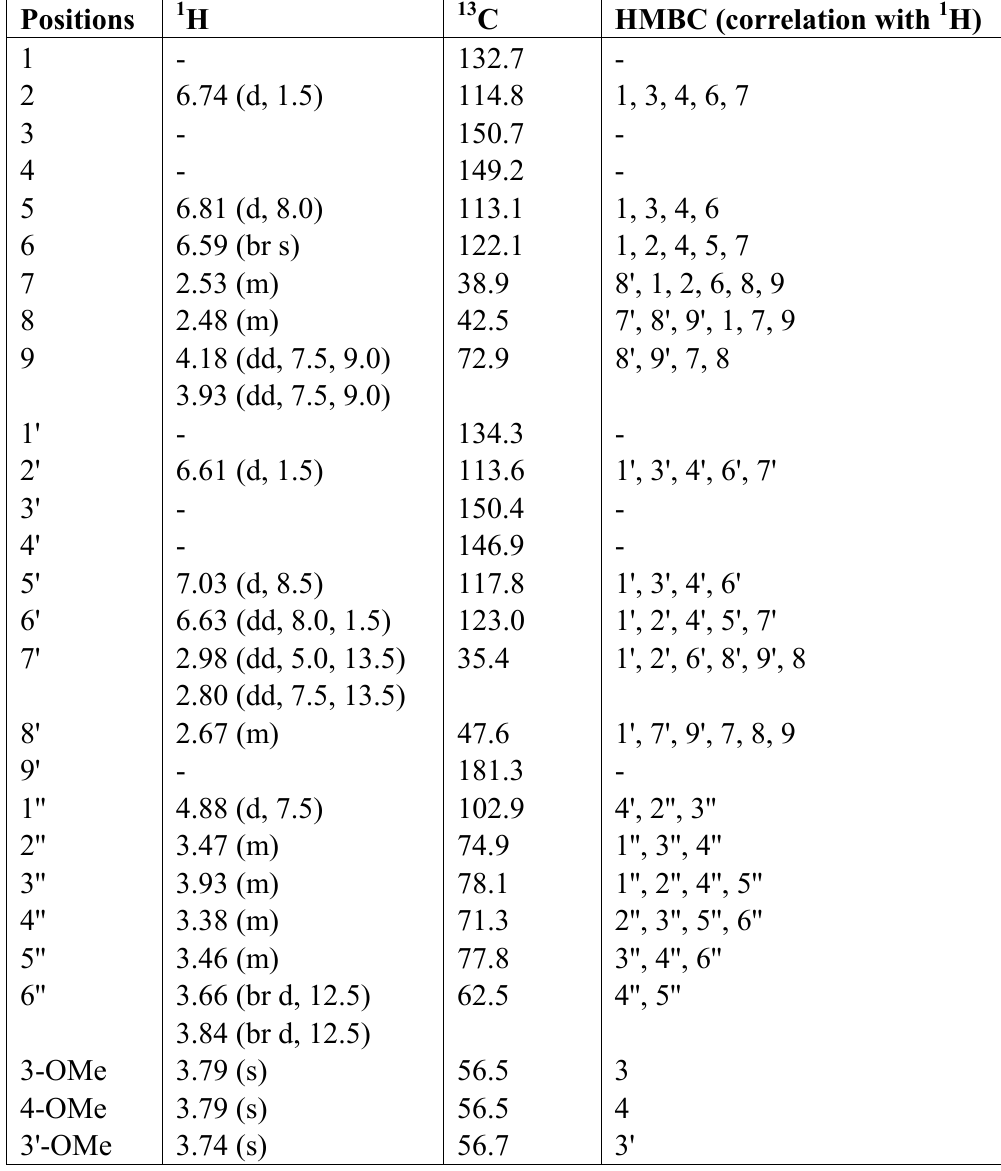
OD, J in Hz and δ in 3